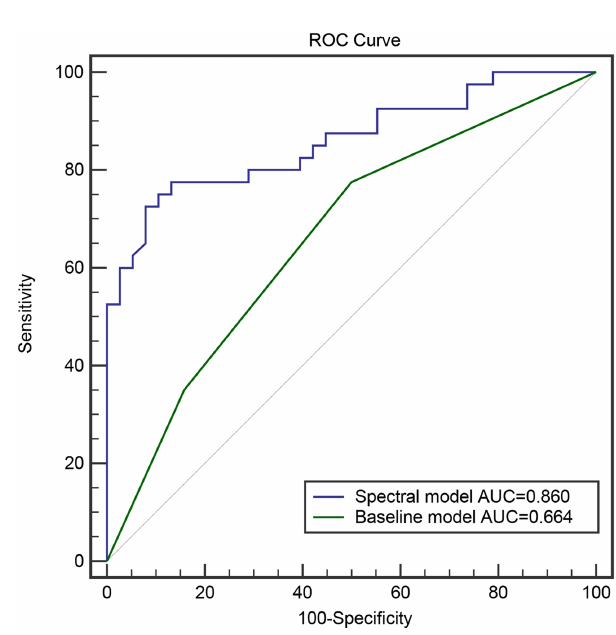
Figure 2. Comparative analysis of ROC curves of the 2